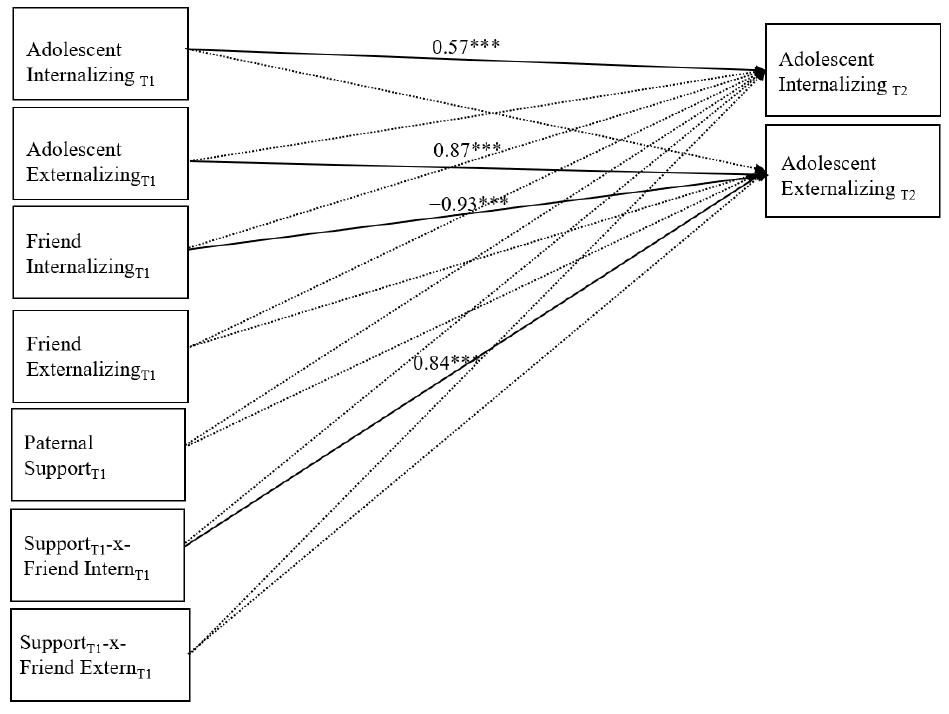
Figure 3. Final path model with paternal support. * p < 0.05, ** p < 0.01, *** p < 0.001 Path coefficients represent the standardized results. Non-significant paths remain in the model and are displayed as dashed lines. Within-time covariances are not displayed for ease of communication, but were tested in the model and reported